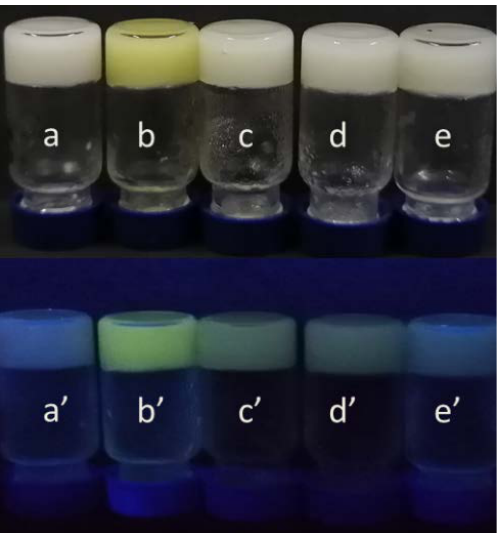
Figure 13. Images of gel 1 from 1,4-dioxane with the addition of Zn 2+ at different concentrations. ( a , a’ ) for the free gel, ( b , b’ ) for 10 −3 M, ( c , c’ ) for 10 −4 M, ( d , d’ ) for 10 −5 M, ( e , e’ ) for 10 −6 M. The upper and lower were under daylight and UV light (365 nm).